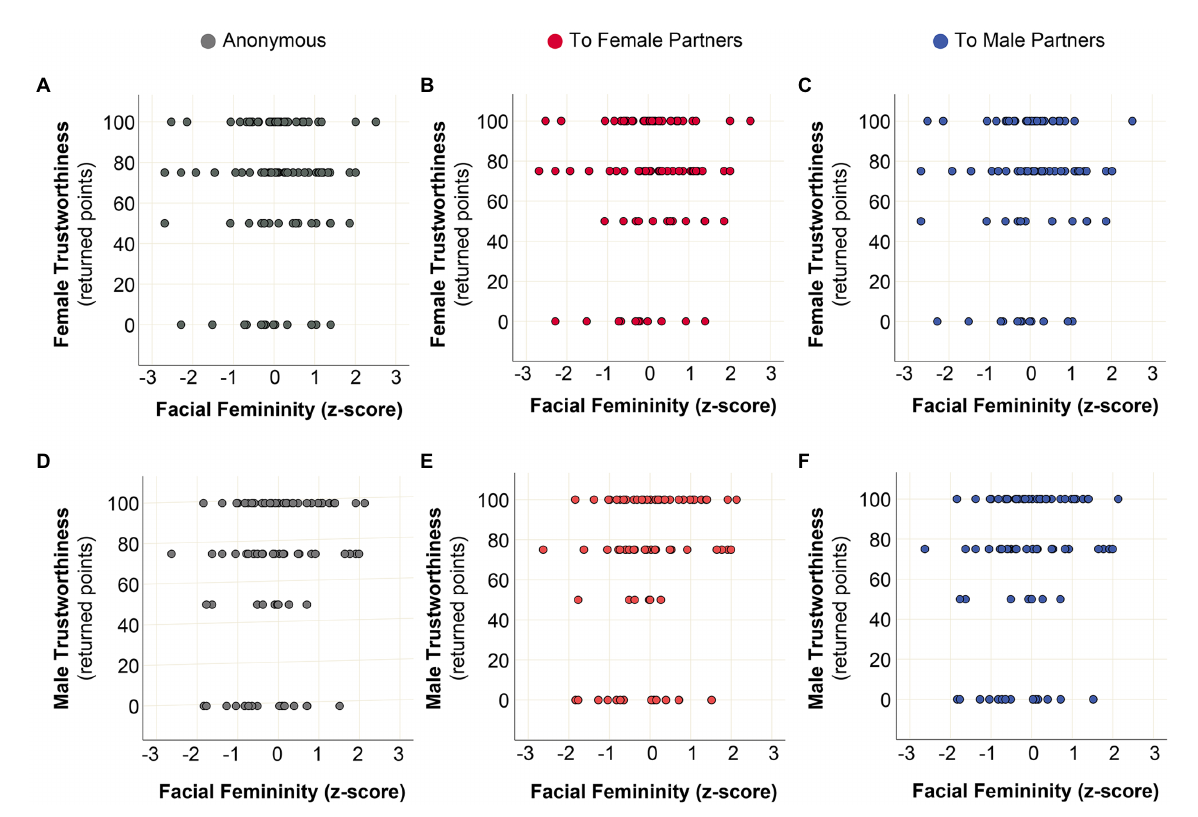
FIGURE 9 Actual trustworthiness, sex, and degree of facial femininity. (A) Linear regression model: response variable–female trustworthiness under anonymous condition; predictor–own facial femininity ( z -score). N = 70; B = 2.999, R 2 = 0.010, p = 0.409. (B) generalized estimating equations (GEE), linear model accounting for repeated measures: response variable—female trustworthiness toward female partners (personalized condition); predictor—own facial femininity ( z -score). N = 139; B = –1.016, Wald X 2 = 0.050, p = 0.823. (C) GEE, linear model accounting for repeated measures: response variable—female trustworthiness toward male partners (personalized condition); predictor—own facial femininity ( z -score). N = 138; B = 6.312, Wald X 2 = 1.171, p = 0.279. (D) Linear regression model: response variable—male trustworthiness under anonymous condition; predictor— own facial femininity ( z -score). N = 71; B = 2.945, R 2 = 0.008, p = 0.463. (E) GEE, linear model accounting for repeated measures: response variable— male trustworthiness toward female partners (personalized condition); predictor—own facial femininity ( z -score). N = 141; B = –0.679, Wald X 2 = 0.023, p = 0.880. (F) GEE, linear model accounting for repeated measures: response variable—male trustworthiness toward male partners (personalized condition); predictor—own facial femininity ( z -score). N = 142; B = –0.216, Wald X 2 = 0.002, p =